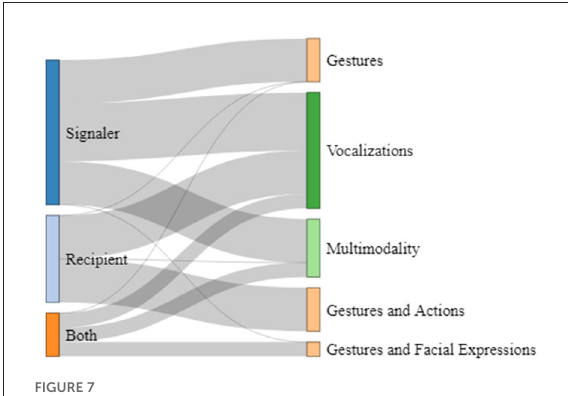
FIGURE7 Components and modalities of turn-taking interactions addressed in the reviewed studies.